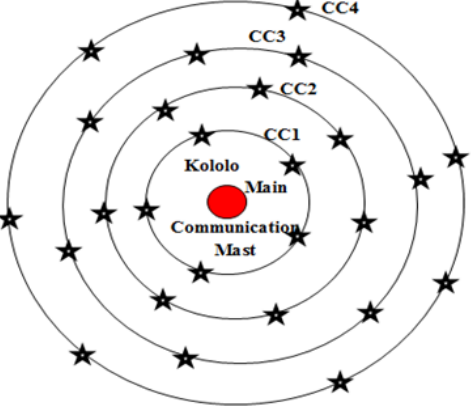
Figure 2. View of the Measurement Locations (MLos) on the concentric circles